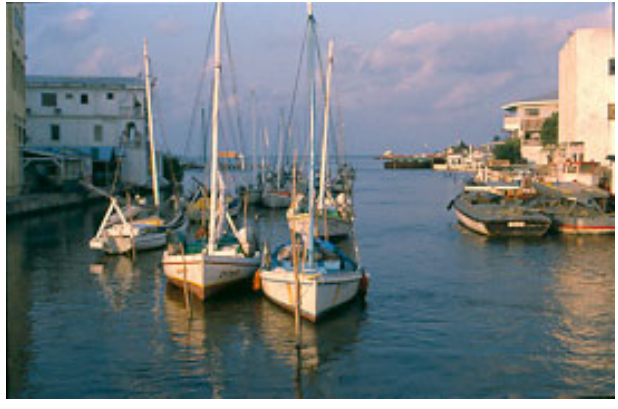
Fig. 5. Sailing smacks moored in Belize